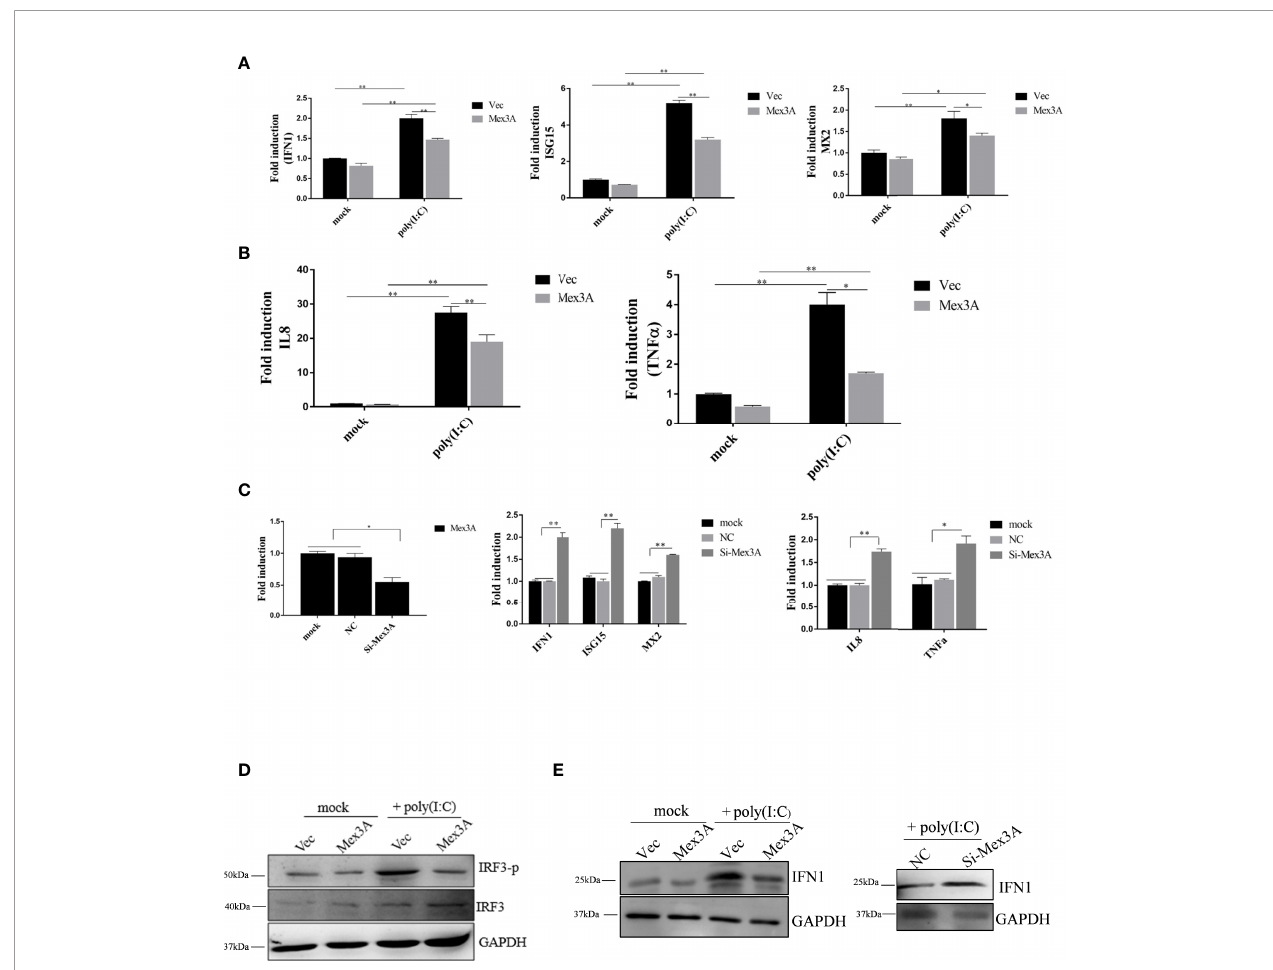
FIGURE 2 | Grass carp Mex3A acts as a negative regulator in innate immunity. (A) CIK cells were separately transfected with 2.0 m g of pcDNA3.1-basic or 2.0 m g of Mex3A-pcDNA3.1 plasmid. Six hours later, the expressions of IFN1 , ISG15 , MX2 , were analyzed by qRT-PCR. b -actin was used as an internal control. (B) CIK cells were transfected with the indicated plasmids. Expressions of IL8 and TNF a were measured and analyzed. (C) CIK cells were separately transfected with 5 m l of NC and 5 m l of Si-Mex3A. At 24 h post transfection, the expressions of Mex3A , IFN1 , ISG15 , MX2 , IL 8 , and TNF a were tested. (D) CIK cells were separately transfected with the indicated plasmids, and the phosphorylation level of IRF3 was detected by Western blotting. (E) The cells were transfected with the indicated plasmids, Western blot was performed with IFN1 antibody, and GAPDH antibody was used as an internal control. The results are representative of three independent experiments. Data are analyzed with ANOVA and presented as mean ± SD. * p < 0.05, ** p <